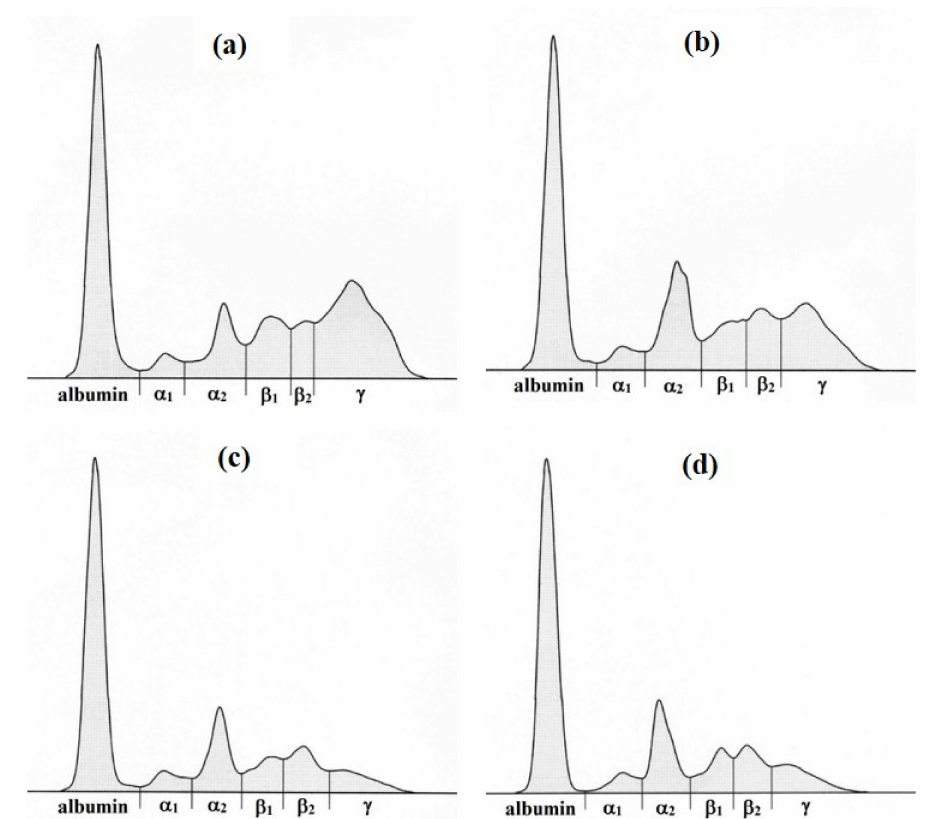
Figure 1. The representative electrophoretograms before ( a ) and following the treatment of Babesia gibsoni infection with Malarone ® , azithromycin and artesunate combination (( b )—negative PCR test, ( c )—day 56, ( d )—day 720) of dog showing the serum protein fractions—albumin, α 1-, α 2-, β 1-, β 2- and γ -globulins.